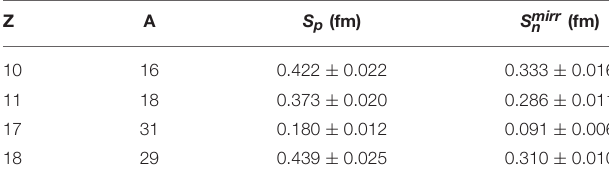
TABLE 2 | Predicted proton skins, S p , for the given Z and A and neutron skins, S mirr n , of the corresponding mirror